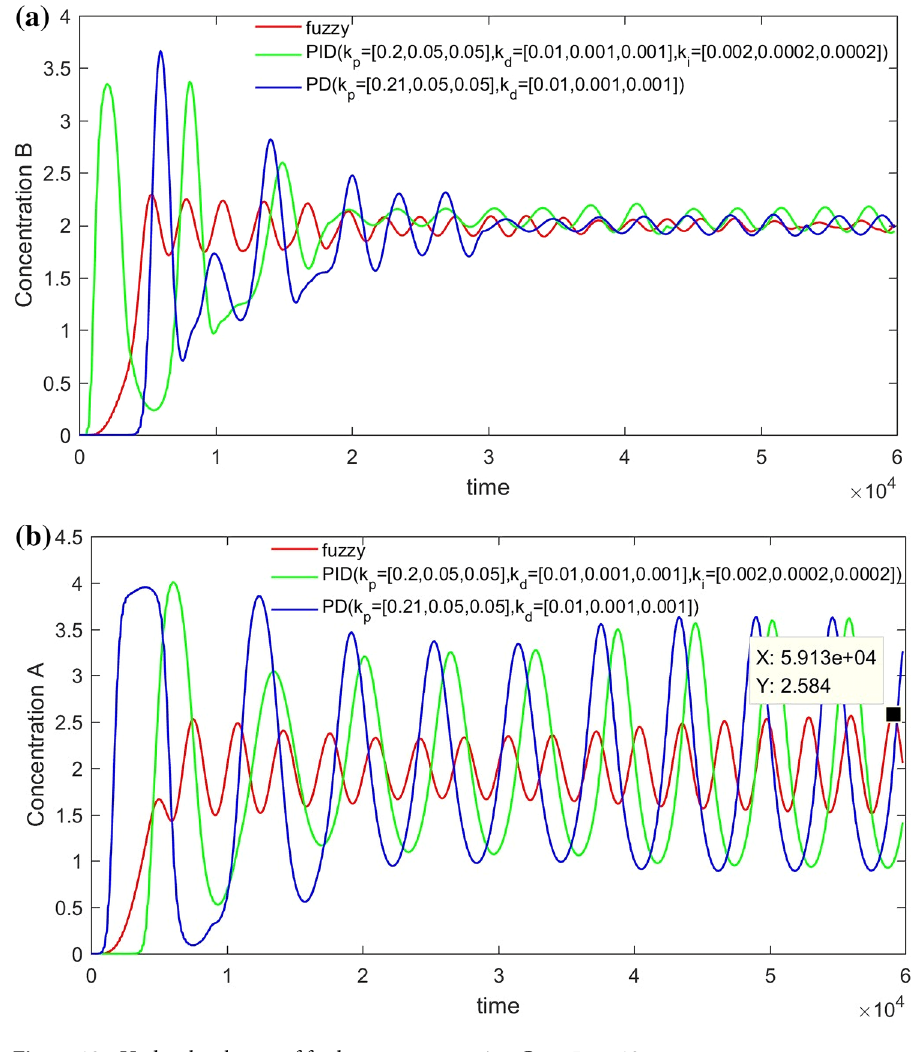
Figure 18. Under the change of feed port concentration C f = 5 → 10